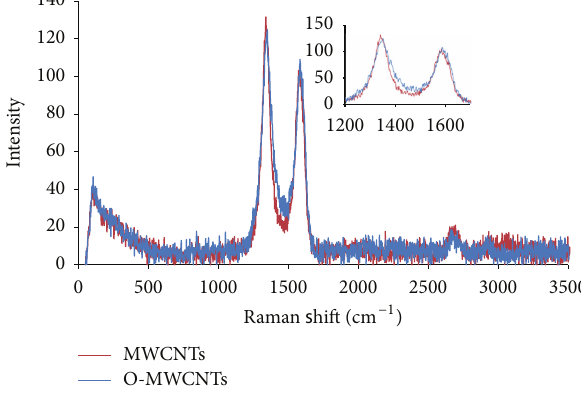
Figure 3: Raman spectra for MWCNTs and